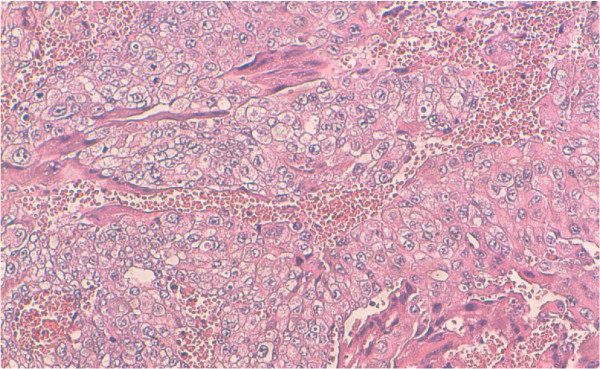
Syncytiotrophoblasts and cytotrophoblasts cells along the hemorrhagic foci (hematoxylin and eosin stain X40).